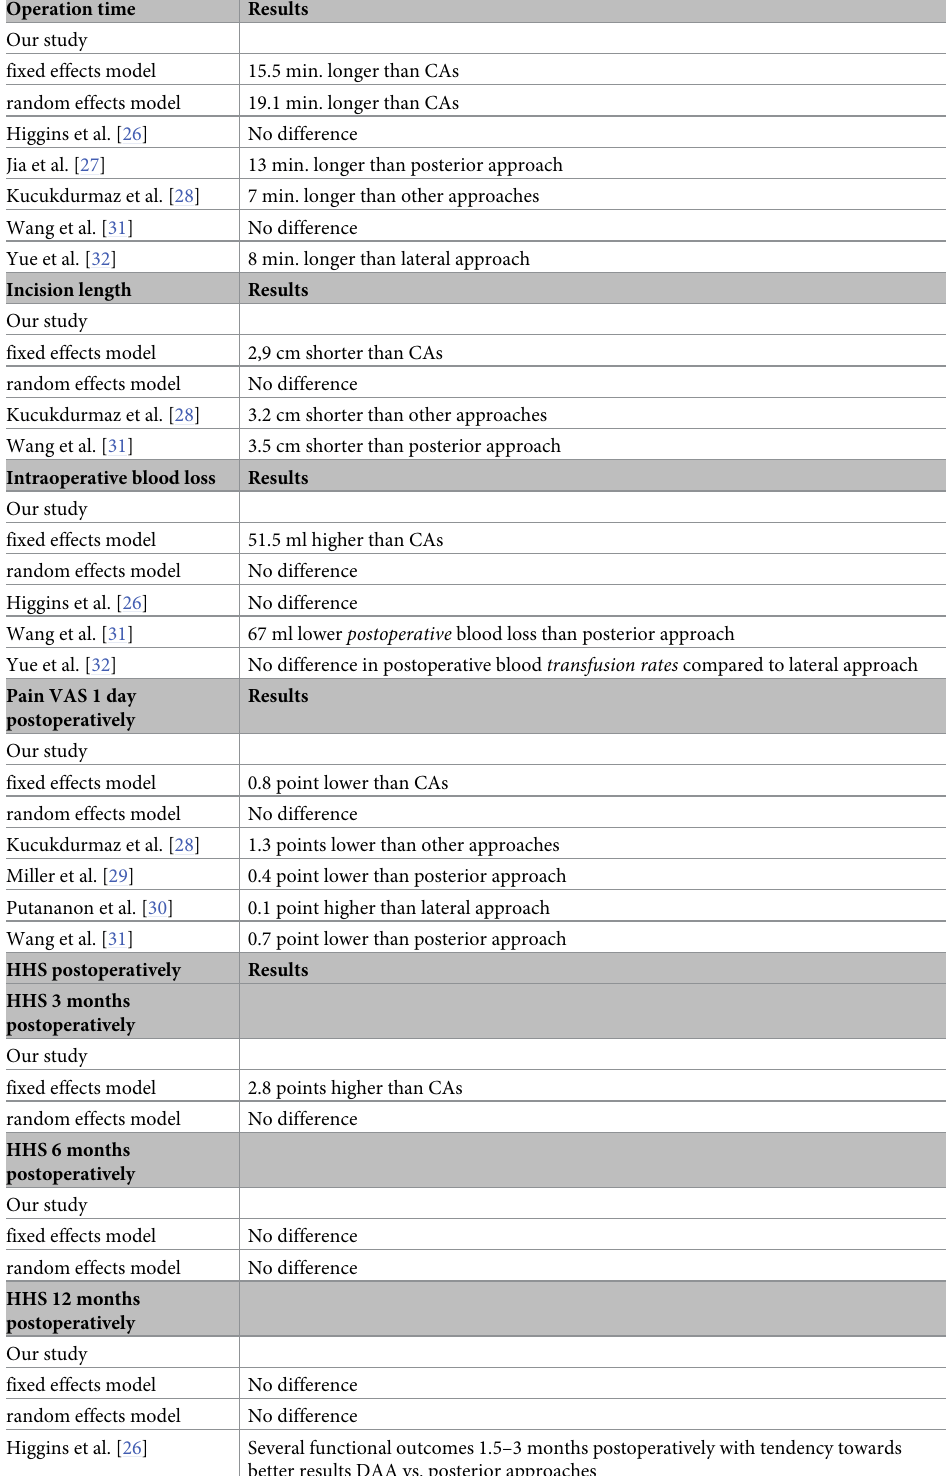
Table 4. Short-term outcomes of THA through DAA compared to other approaches by related